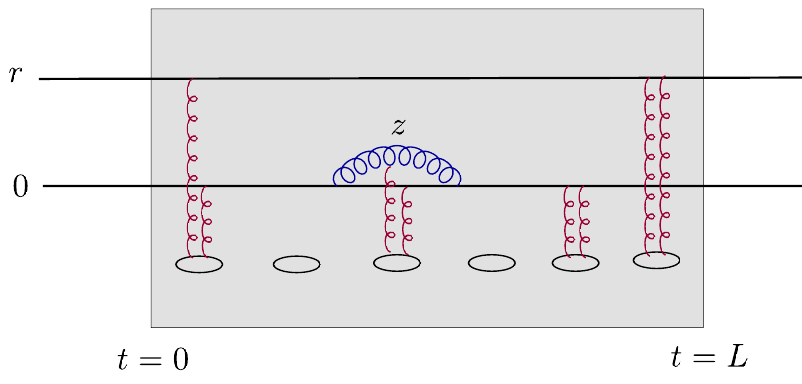
Figure 10 . Pictorial representation of the quantum evolution of the dipole scattering amplitude via the emission of a small-size, short-lived, soft gluon (cid:13)uctuation. The dipole with size r propagates through the target with longitudinal extent L and scatters o(cid:11) the valence quarks via 2-gluon exchanges (in the spirit of the MV model). The gluon (cid:13)uctuation with size z single scattering o(cid:11) the valence quark that it overlaps with in time.